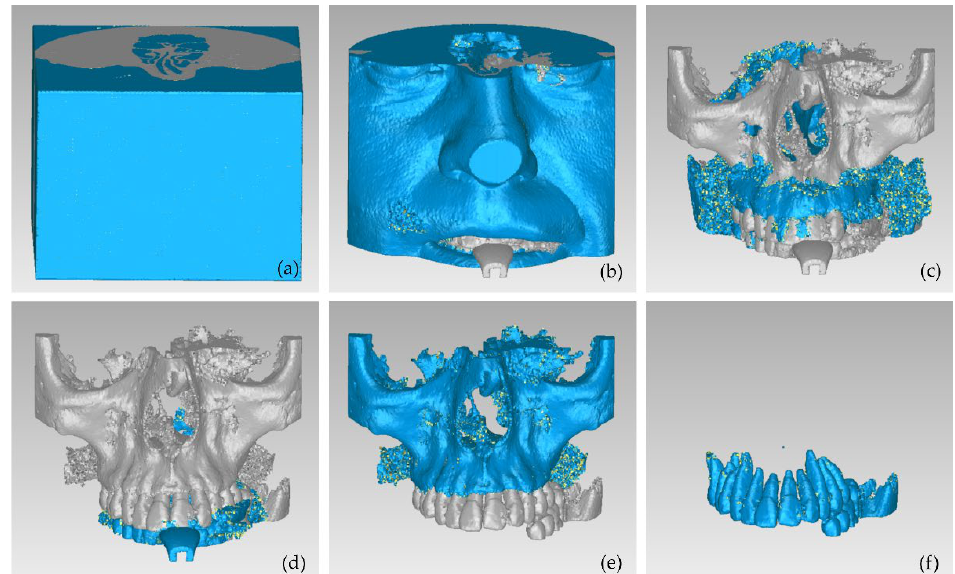
Figure 6. 3D models resulting from the segmentation procedure conducted within Experiment 2, before being processed; ( a ): teeth, alveolar bone, gums, tongue, lips, vacuum (shown in blue); ( b ): teeth, alveolar bone, gums, tongue, lips (shown in blue); ( c ): teeth, alveolar bone, tongue, gums (shown in blue); ( d ): teeth, alveolar bone, tongue (shown in blue); ( e ): teeth, alveolar bone (shown in blue); ( f ): teeth.